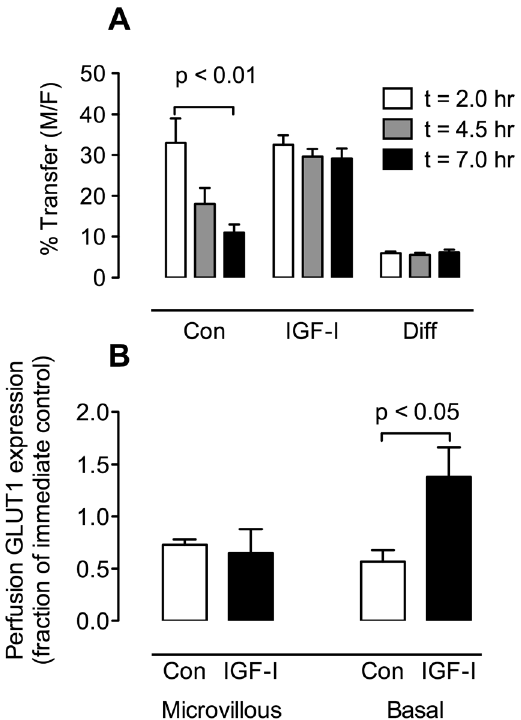
Figure 5. Placental perfusion. Placental perfusion was performed as described in the text, according to the protocol in Figure 4. (A) Maternal-fetal glucose transport . At t=2, 4.5 and 7 hr., samples were taken from the maternal and fetal circulations and the % maternal-fetal transfer of [ 3 H] 3-O-methyl-D-glucose and [ 14 C] L-glucose was calculated for the control perfusions and those that were perfused with IGF-I (100 ng/mL). There was a significant linear decrease in the transfer of [ 3 H] 3-O-methyl-D-glucose in the control perfusions over time (p , 0.01, repeated measures ANOVA, linear trend post test; n=4) whereas there was no change in % transfer in the IGF-I perfusions. In addition, no changes were noted in the diffusional transfer component in either the control or experimental group, shown here as the combined data. (B) GLUT1 protein expression . Immediately prior to perfusion, tissue samples were taken from non-perfused areas for preparation of microvillous and basal membrane fractions (immediate controls). After perfusion, the perfused lobules were dissected out and used for preparation of microvillous and basal membrane fractions. The two membrane fractions were slot-blotted to determine GLUT1 protein expression. The results show the effects of IGF-I on microvillous and basal membrane GLUT1 in the perfusions as a fraction of the GLUT1 protein expression in the respective immediate control samples. In the microvillous and basal samples from control perfusions there was a decrease in GLUT1 relative to the expression prior to perfusion. A similar result was obtained for the basal membrane from the control perfusion, however the basal membrane GLUT1 expression from the IGF-I perfusion was increased (p , 0.05, one sample t test,